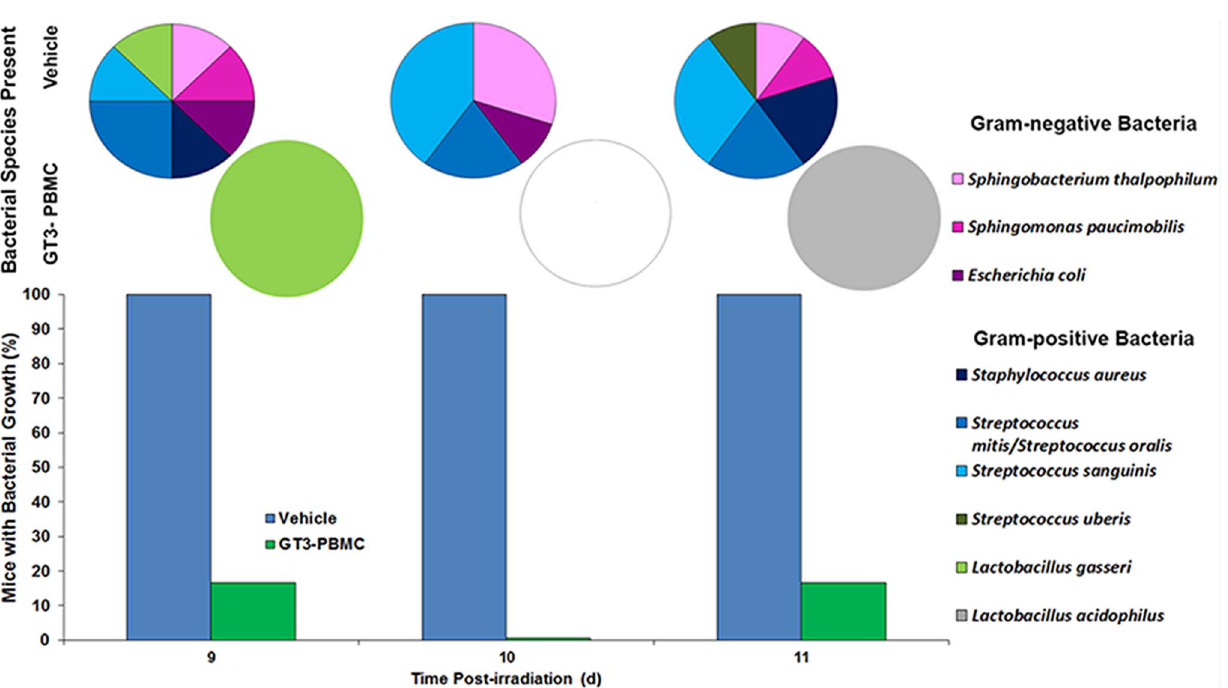
Figure 4. Bacterial translocation in GT3-mobilized PBMC recipient mice. Mice were transfused with 5 million PBMC from GT3-injected mice and compared with control group. Heart blood, spleen, and liver samples were collected aseptically on days 9, 10, and 11 days post 11 Gy 6 ˚ Co c -irradiation. Samples were inoculated onto agar media using the conventional four-dilution-streak method and monitored for bacterial growth. Isolated bacteria were identified with Vitek 2 Compact automated